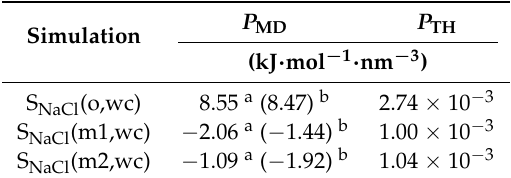
Table 4. Disjoining pressure between successive bilayer copies, evaluated via Equation (6) ( P MD ) and Equation (7) ( P TH ). The simulation acronyms are explained in Table